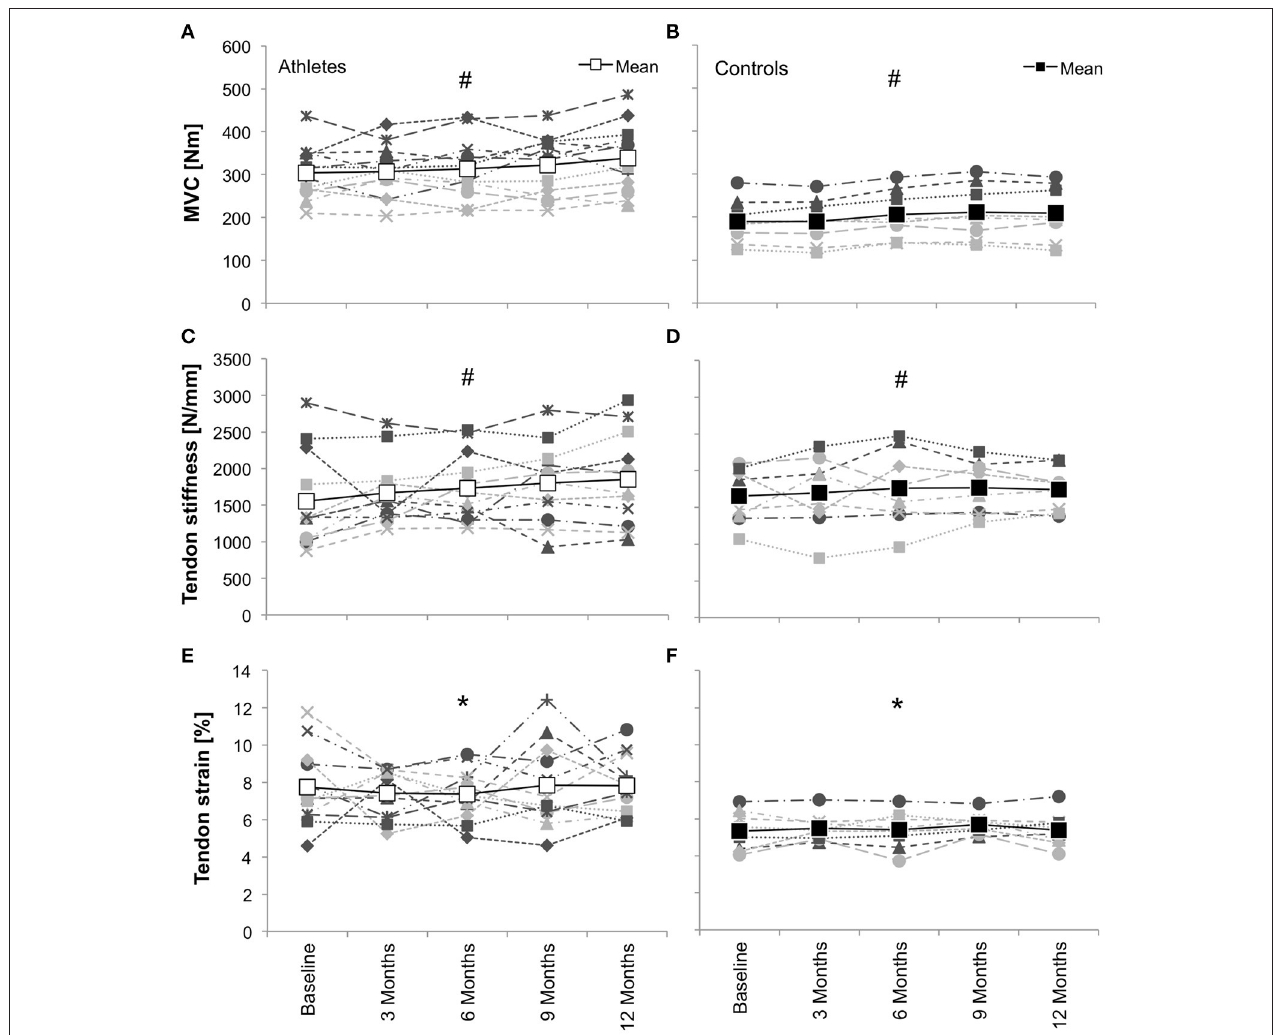
FIGURE 2 | On-year development (in 3-month intervals) of knee extensor muscle strength (MVC; A,B ), patellar tendon stiffness (C,D) and tendon strain during maximum contractions (E,F) in adolescent volleyball athletes ( n = 12; A,C,E ; white symbols show mean values) and controls ( n = 8; B,D,F ; black symbols show mean values), including individual data of female (light gray) and male participants (dark gray) in both groups. *Significant difference between groups (i.e., intercept; p < 0.05); # significant change over time (i.e., slope; p < 0.05). Note that differences between groups were not tested for MVC and stiffness. The data shows greater fluctuations of muscle strength in the athletes and, as a result of an imbalanced adaptation of muscle and tendon, both greater average tendon strain during maximum contractions as well as greater fluctuations of strain over time (Mersmann et al., 2016, with permission from American Physiological